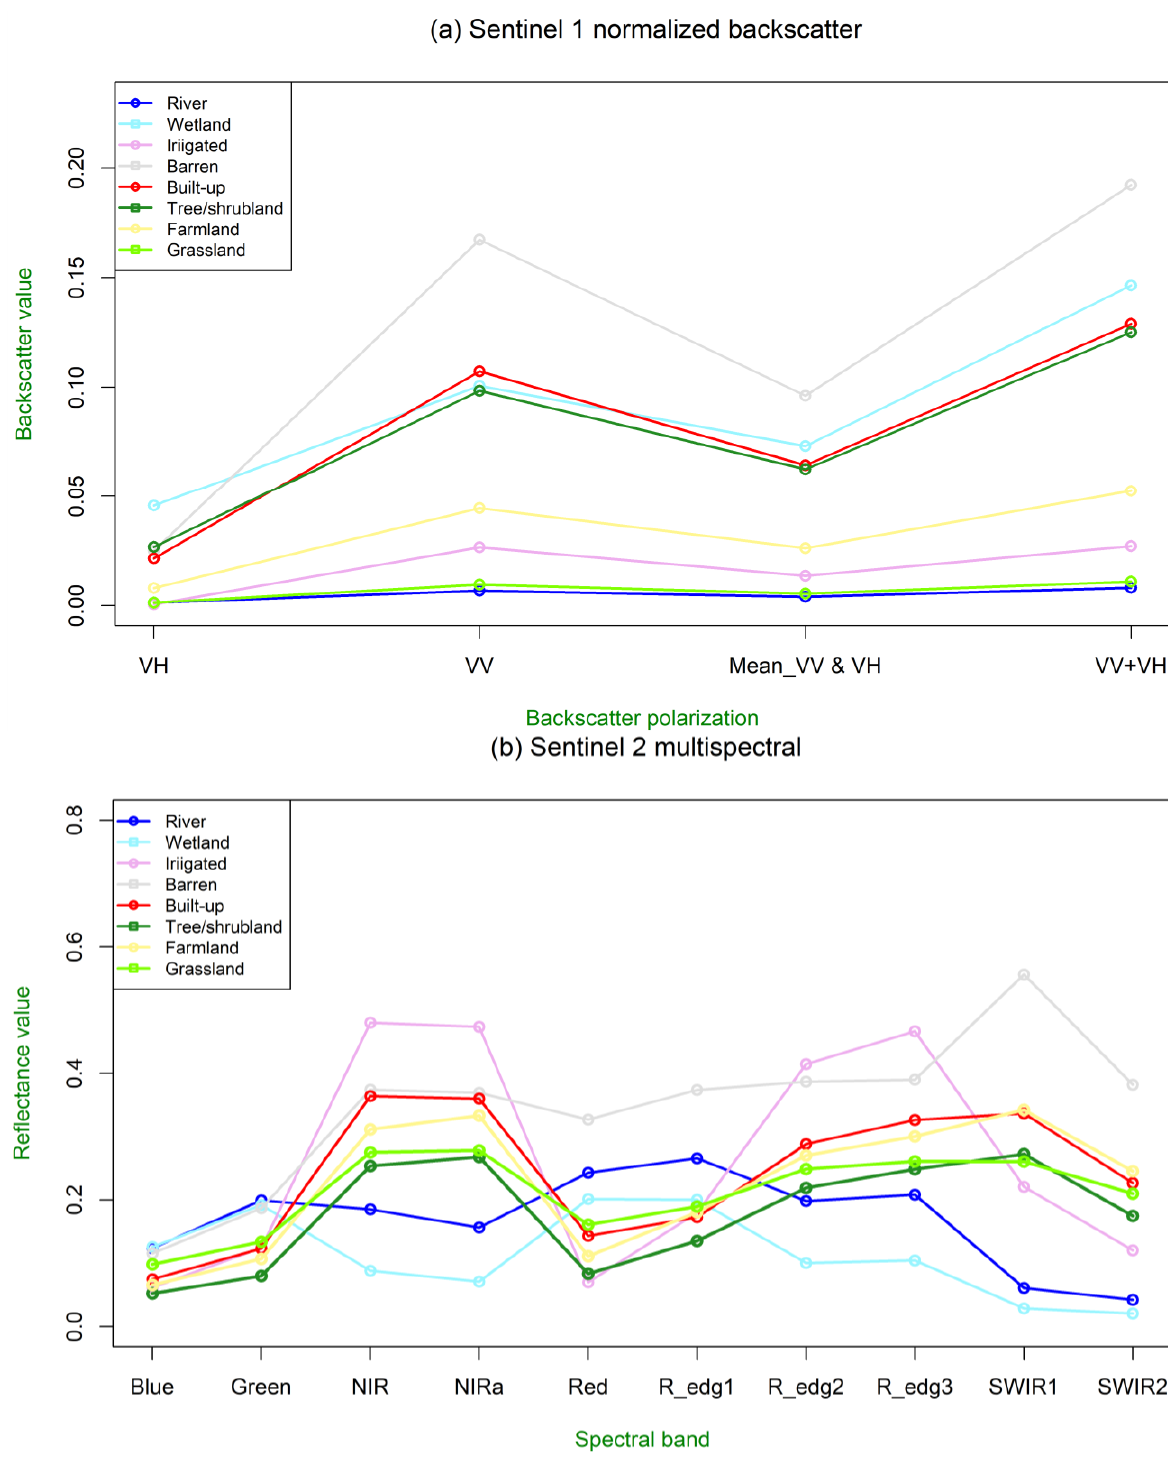
Figure 3. ( a ): Spectral curves of the LULC categories derived from the Sentinel-1 normalized backscatter, ( b ) spectral curves of the LULC categories derived from the Sentinel-2 normalized backscatter.